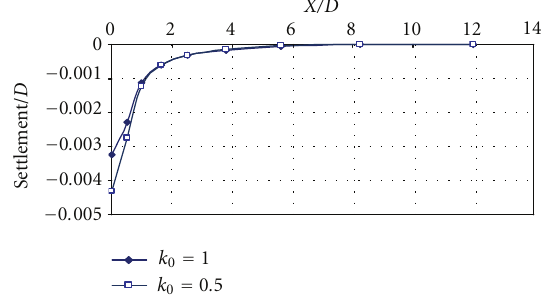
Figure 22: Variation of surface settlement at di ff erent times using reduced k 0 values.